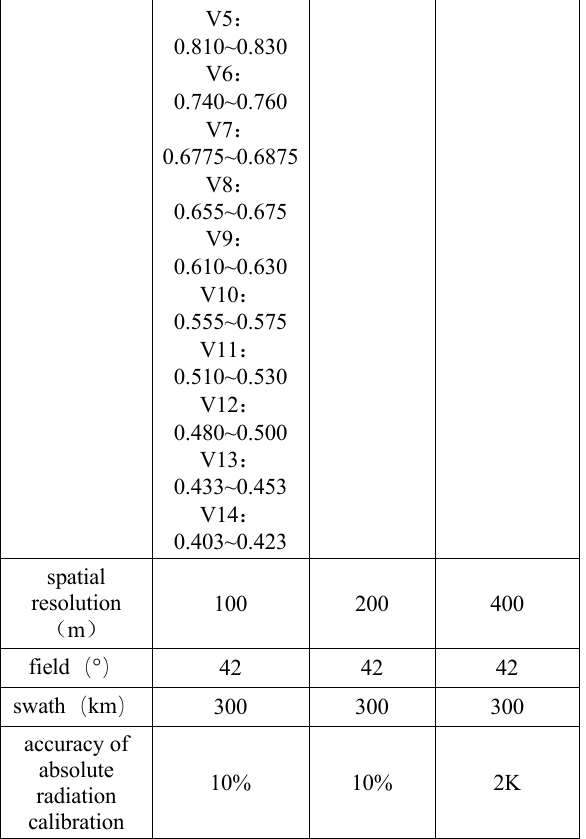
Table 1 . Data index of wide-band imaging spectrometer The Interferometric Imaging Radar Altimeter (InIRA) is the first microwave remote sensor with wide swath, accurate measurement of ocean topological height and three-dimensional land and sea morphology, which adopts the technologies of small incidence angle short baseline interference, aperture synthesis and height tracking. The spatial resolution of 3D imaging microwave altimeter interferometry observation: the ocean is 10km × 10km, and the altimetry accuracy is better than 8.2cm; the land is 200m × 200m, and the altimetry accuracy is better than 10m; the spatial resolution of 2D imaging is 40m × 40m. Data